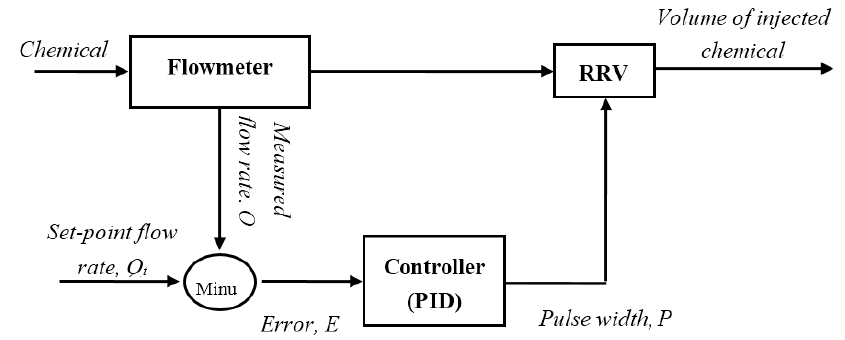
Figure 4. Block diagram of the closed-loop control.